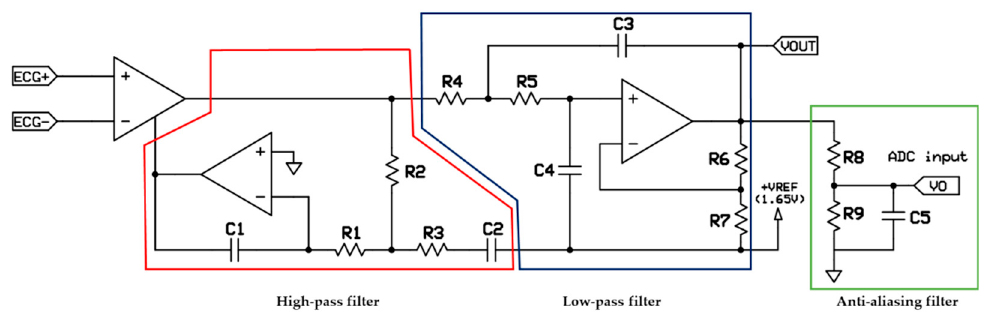
Figure 4. Simplified schematic of filters topology using the AD8232 configuration.